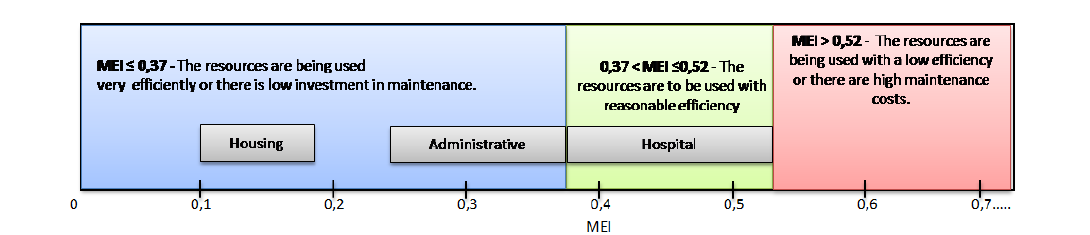
Figure 6: MEI classification (adapted from Shohet [14]).